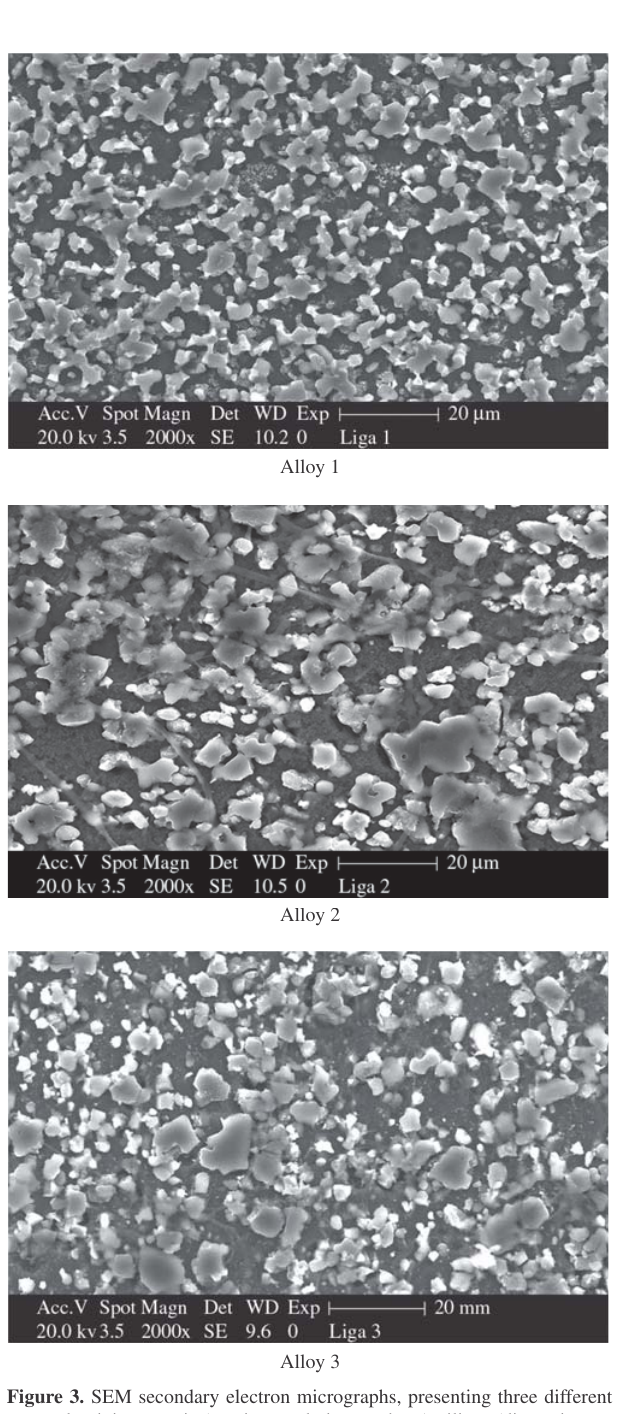
Figure 3. SEM secondary electron micrographs, presenting three different areas: aluminium matrix (continuous dark grey phase), silicon (discontinuous medium grey phase) and copper rich intermetallics (light grey phase).